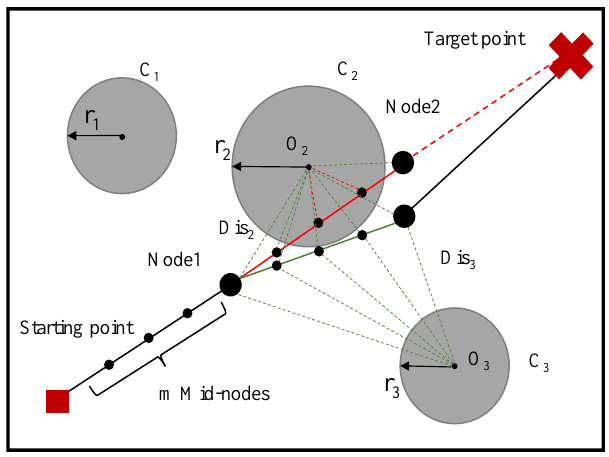
Figure 3. The concept of mid-node introduced to avoid obstacles.